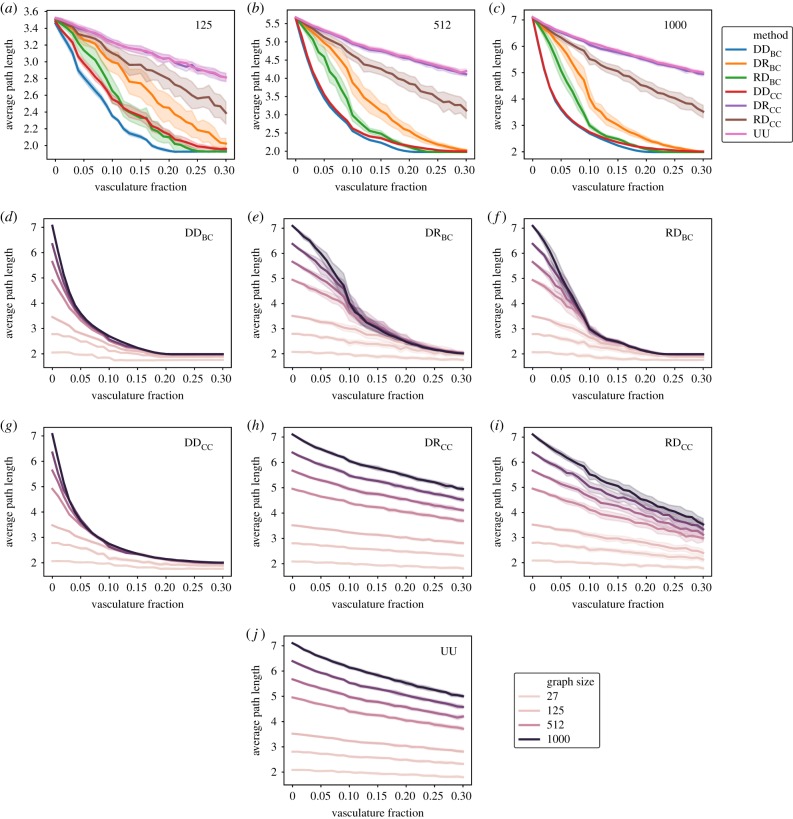
Average path length scaling for an increasing fraction of cells converted to vasculature in noisy 3D hexagonal lattices. Comparison between the different methods described in the Methods section (a–c). For graphs of constant size (a) 125, (b) 512 and (c) 1000, we show the effect of node fusion following the high betweenness (DDBC), roulette wheel then highest value betweenness (RDBC), highest value then roulette wheel betweenness (DRBC), high closeness (DDCC), roulette wheel then highest value closeness (RDCC), highest value then roulette wheel closeness (DRCC) and random methods (UU). Scaling for each of the methods in different graph sizes (d–j). Exploration of the methods (d) DDBC, (e) DRBC, (f) RDBC, (g) DDCC, (h) DRCC, (i) RDCC and (j) R in graphs ranging from 27 to 1000 nodes. All data points contain 25 replicates; shaded regions represent a standard deviation of the sample.